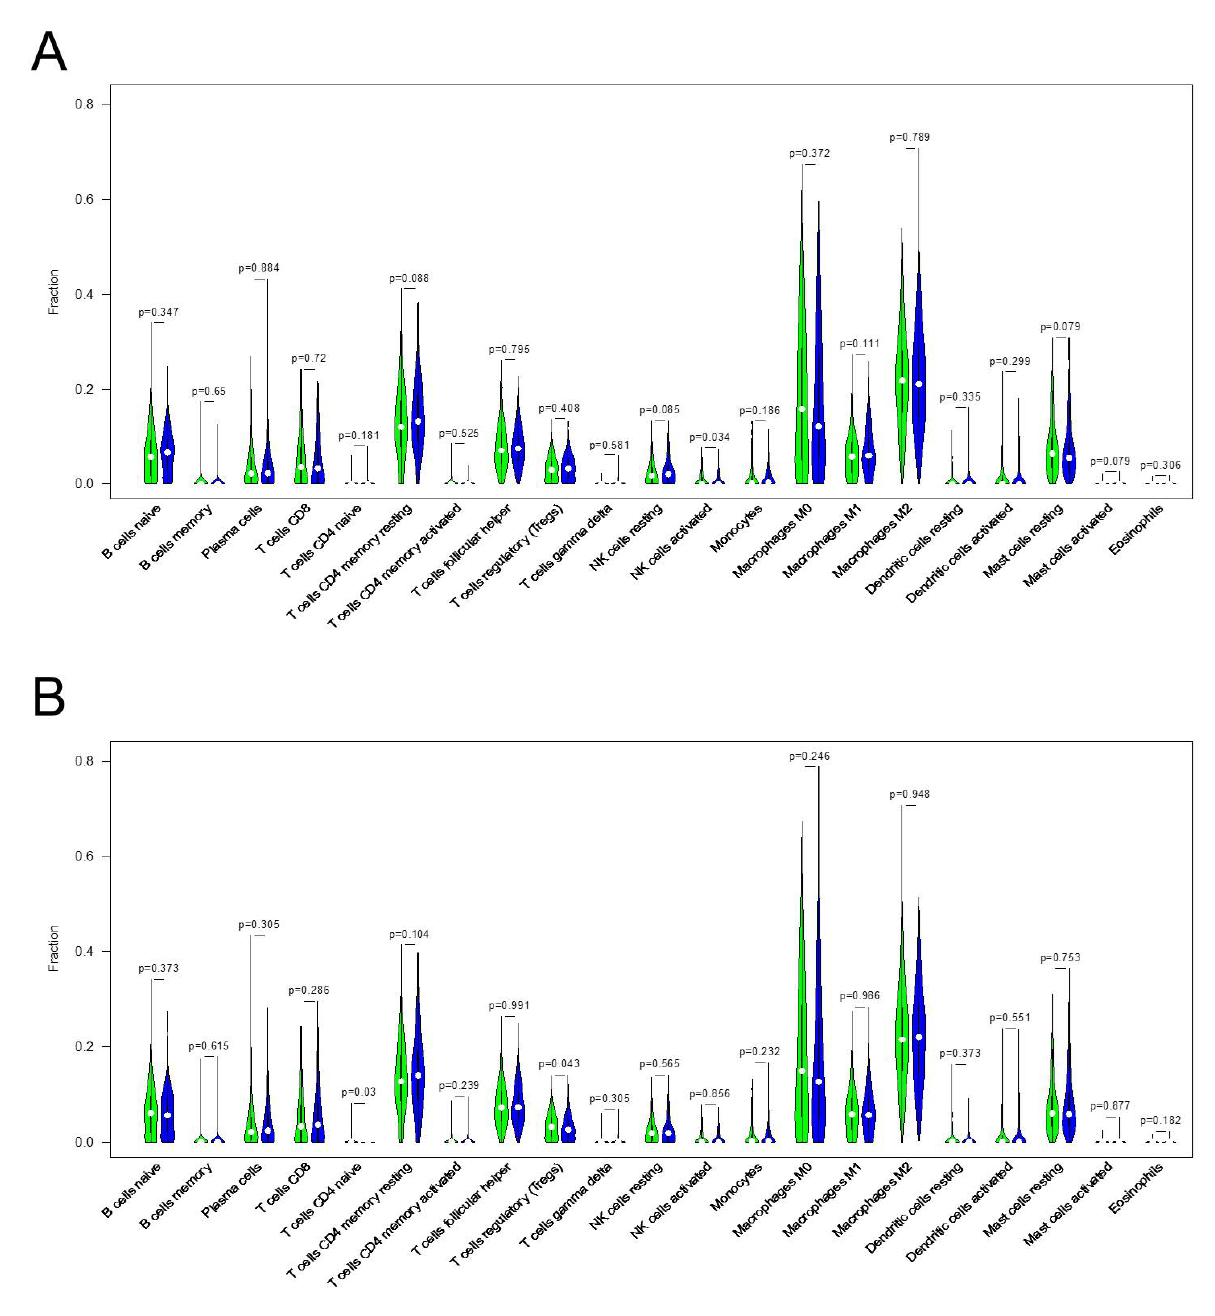
Figure 5. Correlation between KRT17 expression and immune cell infiltration in ( A ) HER2 high and ( B ) ER high ( B ) ER high BC.